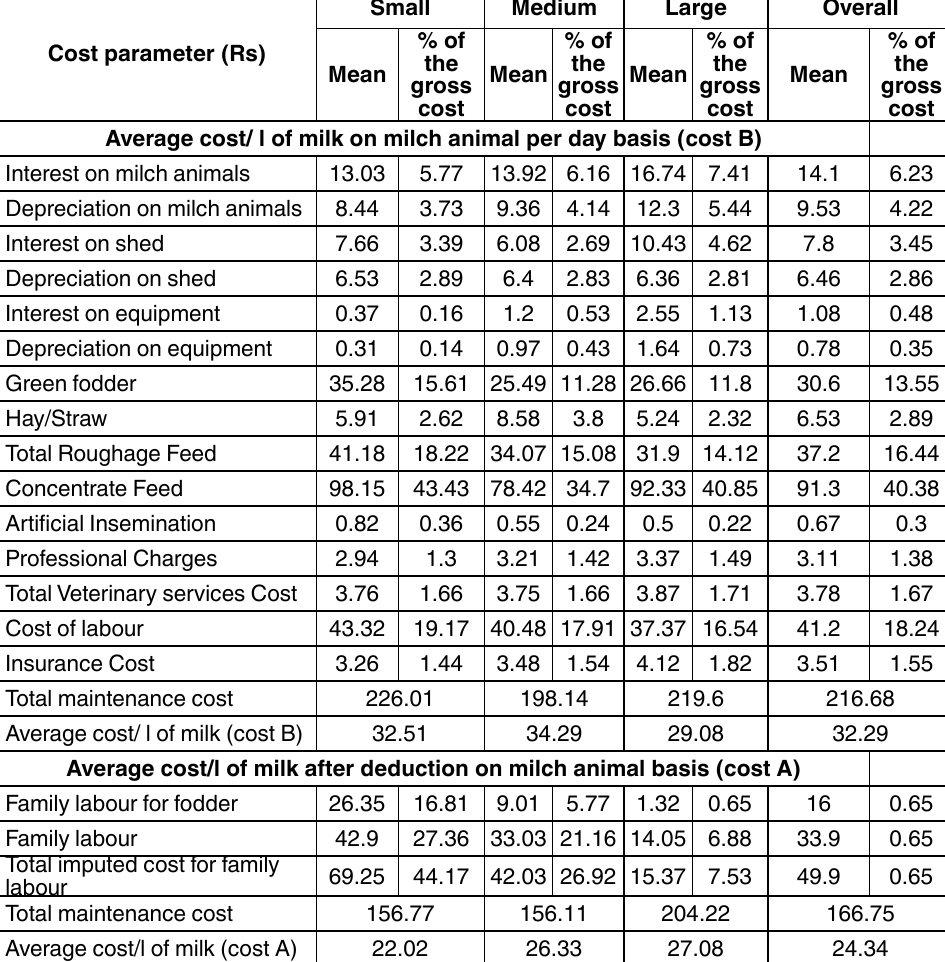
Table 2. Cost of milk production per litre on milch animal basis in small, medium, large and overall average value of all the farms Cost parameter (Rs)